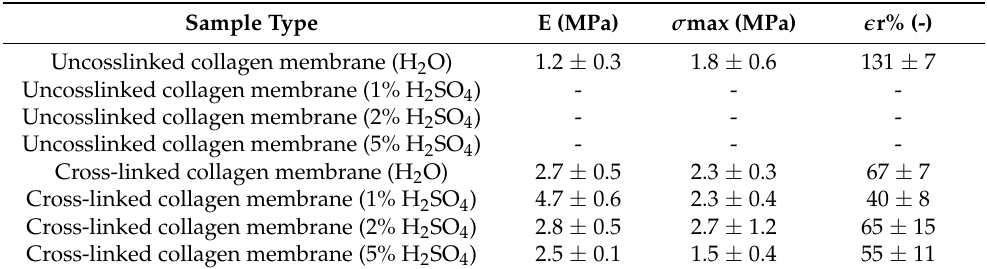
Table 3. Mechanical properties of uncrosslinked and cross-linked collagen matrices in the presence of water and of aqueous electrolytes in terms of Young’s modulus (E), maximum stress ( σ max ), and strain at break ( ε r). Reported values represent mean ± SD, where n = 3.